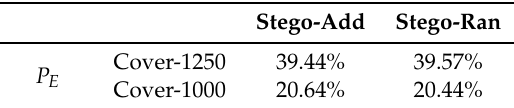
Table 4. The comparison of undetectability results between Cover-1250, Cover-1000 with different embedding contents.